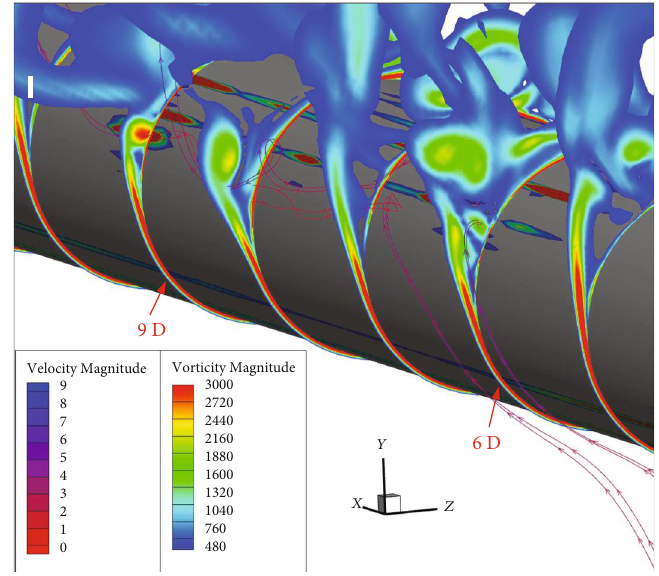
Figure 45: Vorticity at section x = 6 D and x = 9 D in Model